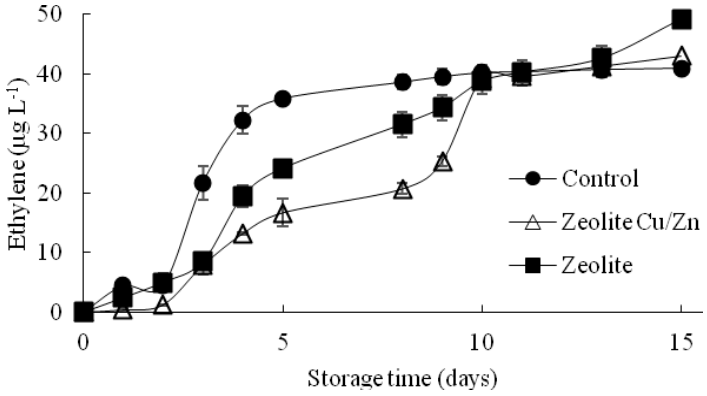
Figure 3. Ethylene concentration for tomato storage over time for different treatments.